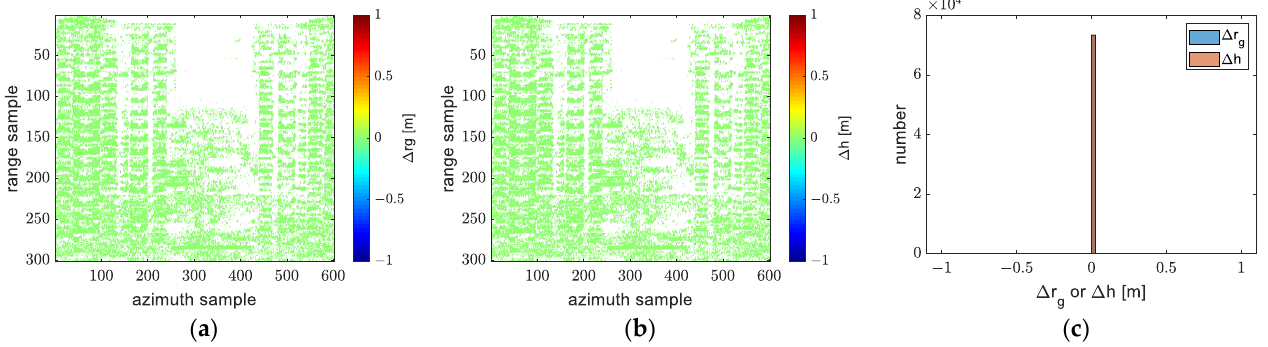
Figure 27. The ground range and height error between transformed model 1 and model 5: ( a ) the ground range error; ( b ) the height error; ( c ) a histogram of ground range and height error.